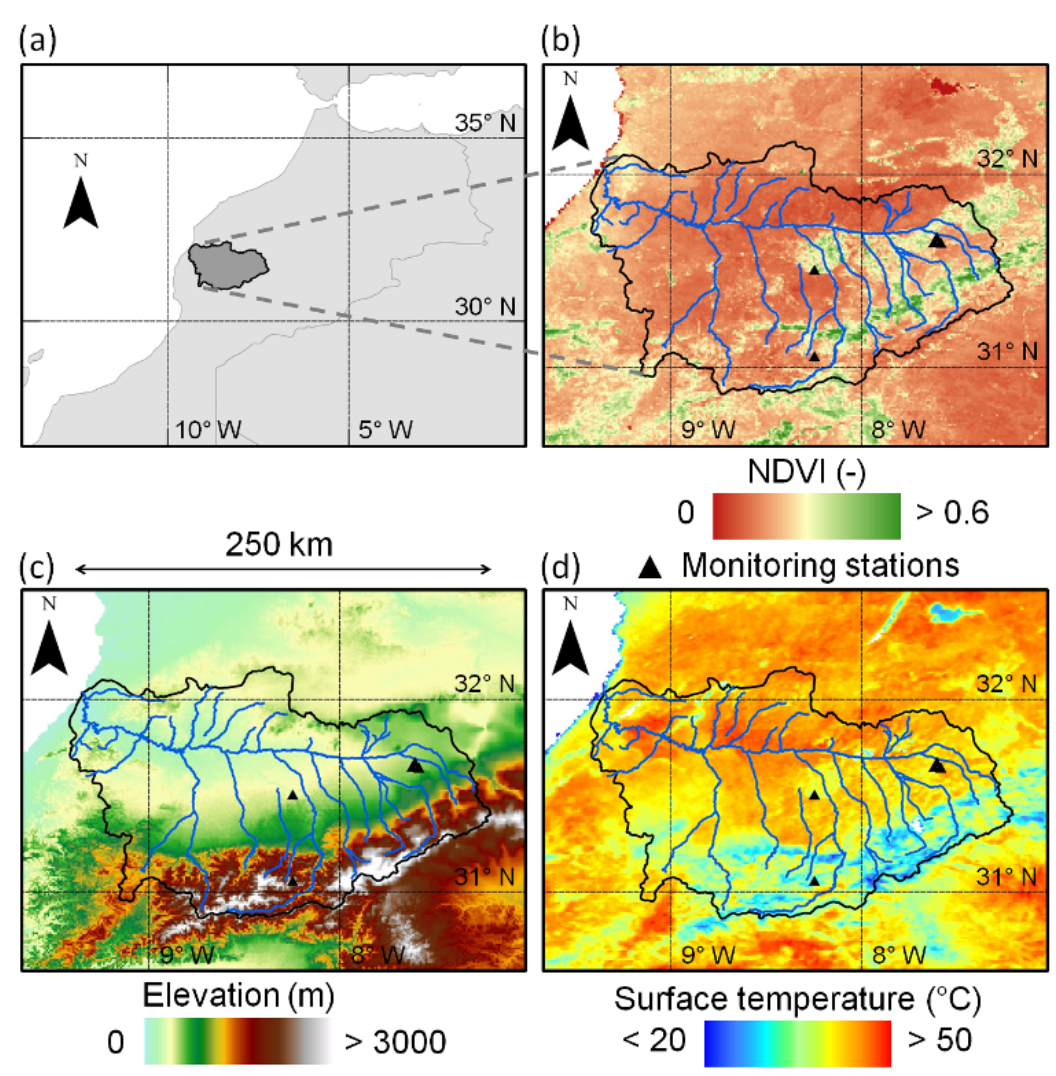
Figure 1. ( a ) Overview map of the Tensift basin in Morocco and ( b ) images over the Tensift basin of MODIS NDVI, ( c ) elevation and ( d ) MODIS land surface temperature on 5 October